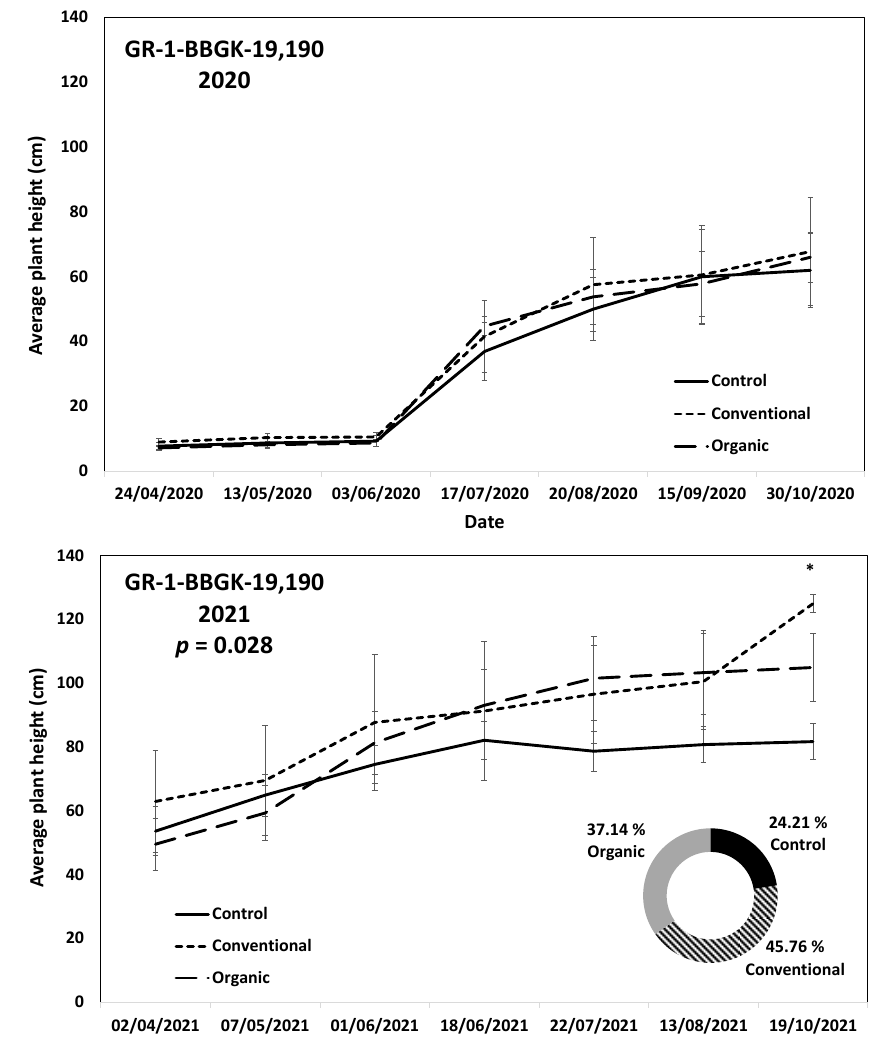
Figure 2. Plant growth patterns expressed as average plant height (cm) for Cornus mas genotype GR-1-BBGK-19,190 during the first two years of the pilot field trial (2020 and 2021) for the three fertilization treatments applied (control, conventional, and organic). Standard errors of the means are shown on the graphs ( p < 0.05). The treatment effects over time (within-subjects effects) were assessed via a Repeated Measures ANOVA separately for each year and were found significant in both cases ( p < 0.05). In 2021, where significant fertilization treatment effects (not over time, between-subjects effects) were observed, the respective p -value is given, coupled with asterisks that denote dates when significant differences between treatments were observed after discreet analyses for each measurement date via Tukey’s HSD mean comparison ( p < 0.05). In the 2021 graph, the rate of juvenile growth expressed as percentage (%) of tree height increase between 6 and 18 months after planting for each fertilization treatment measured independently, is comparatively given in a circular